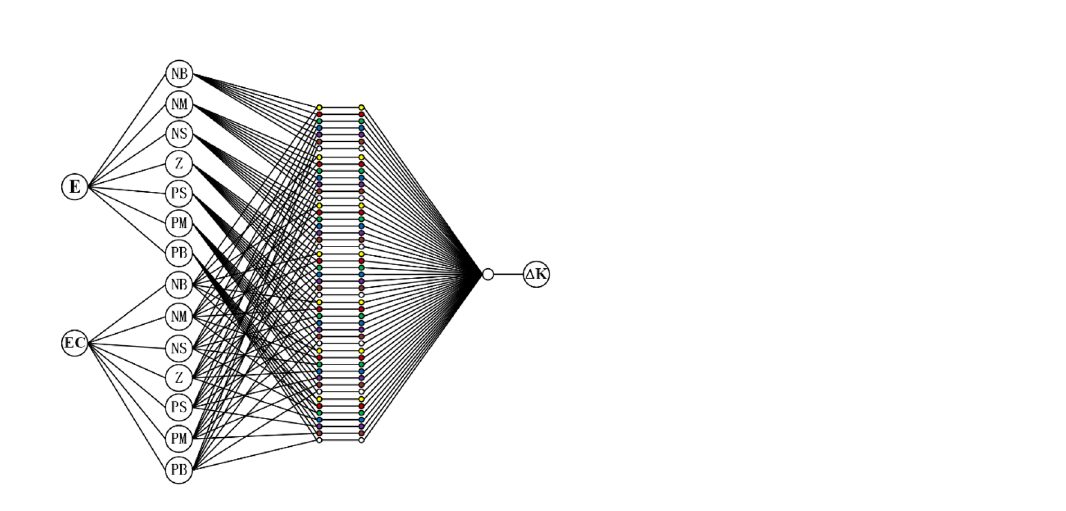
Figure 10. Adaptive neural fuzzy control